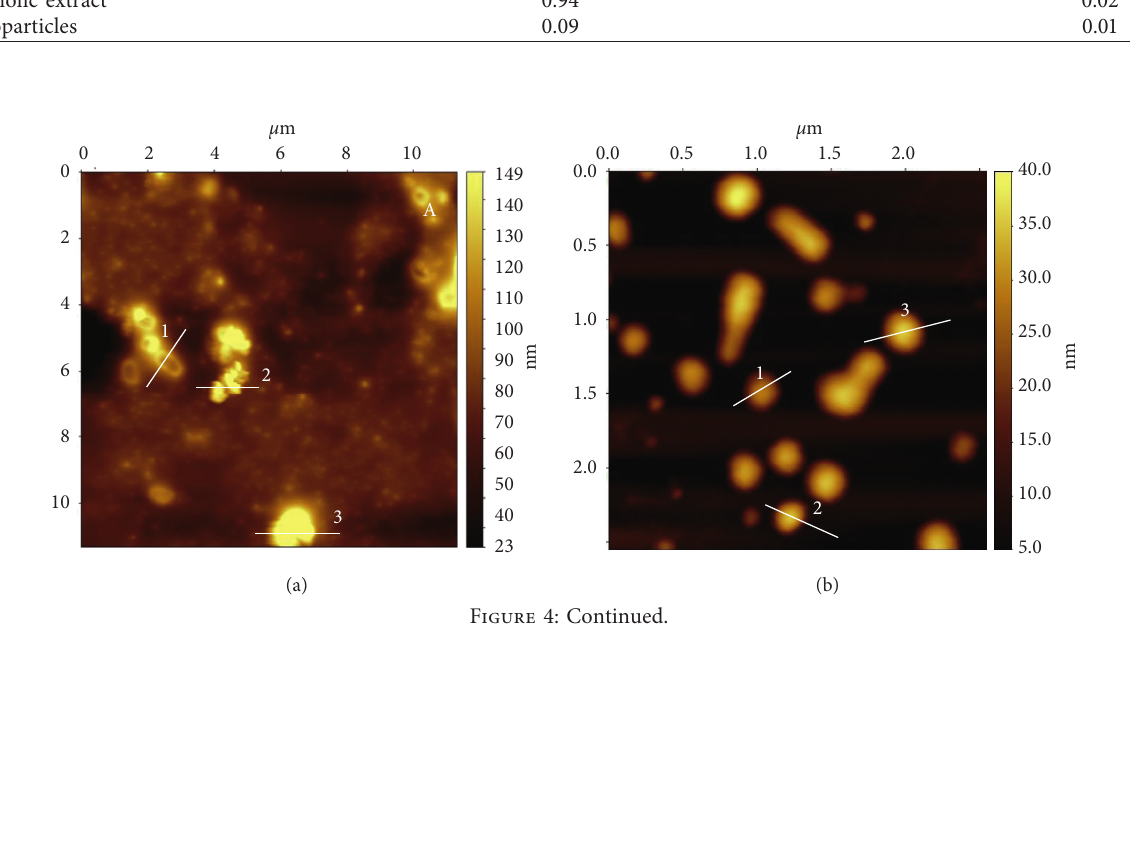
Figure 3: (a) 13 C-NMR and (b) 1 H-NMR of the TEC-NP suspension dried and redissolved in CDCl Table 6: Phenol quantification by the Folin–Ciocalteu method for Tinospora cordifolia ethanolic extract and nanoparticles.